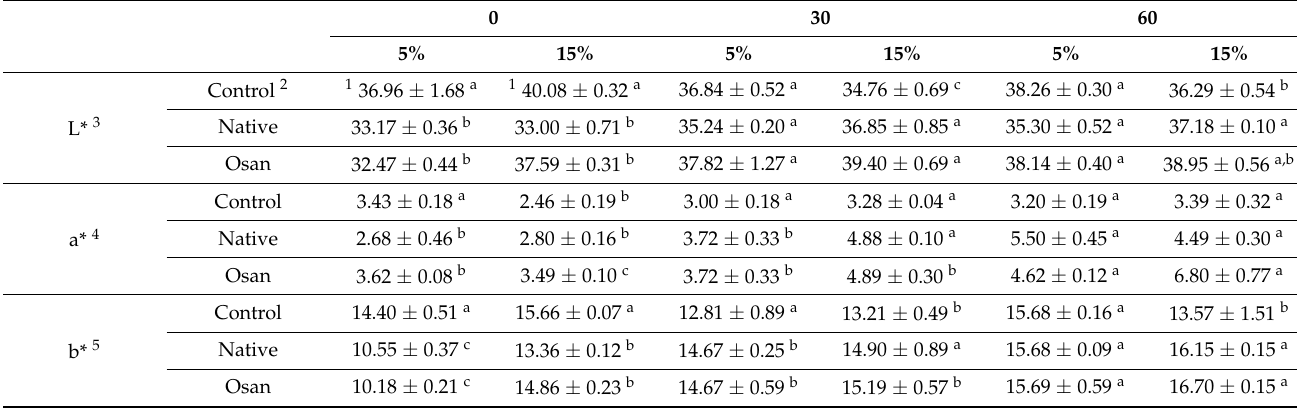
Table 7. The effect of octenyl-succinylated (Osan) corn starch, native starch, and animal fat on the color characteristics of un-cooked meat patties at − 20 for different days.